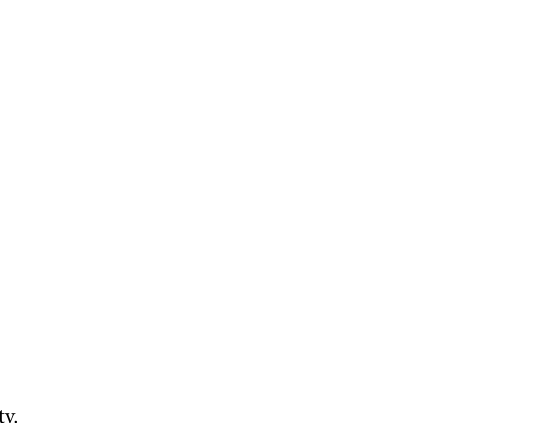
Figure 13. Reconstruction results of conductivity.